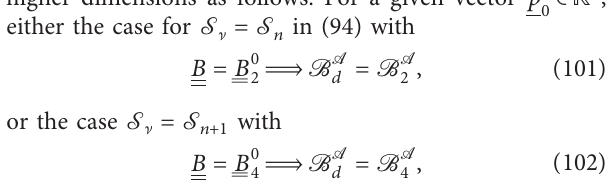
, β ) � ( μ , − at ( β Q 2 1 2 φ (dashed β 1 , β 2 ) ∈ B 2